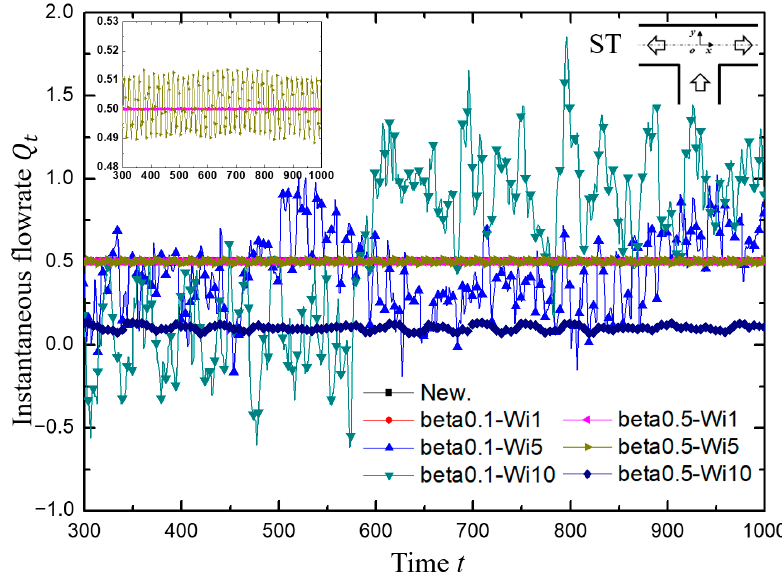
Figure 7. The variation of instantaneous flow rate 𝑄 𝑡 at the left outlet with dimensionless time. Inset: For the cases of Newtonian fluid, beta0.1-Wi1, beta0.5-Wi1 and beta0.5-Wi5, the y -axis ranges are set to 0.48 to 0.53 to display more clearly, where the former three cases are nearly collapsed into a line with a value of 0.5.